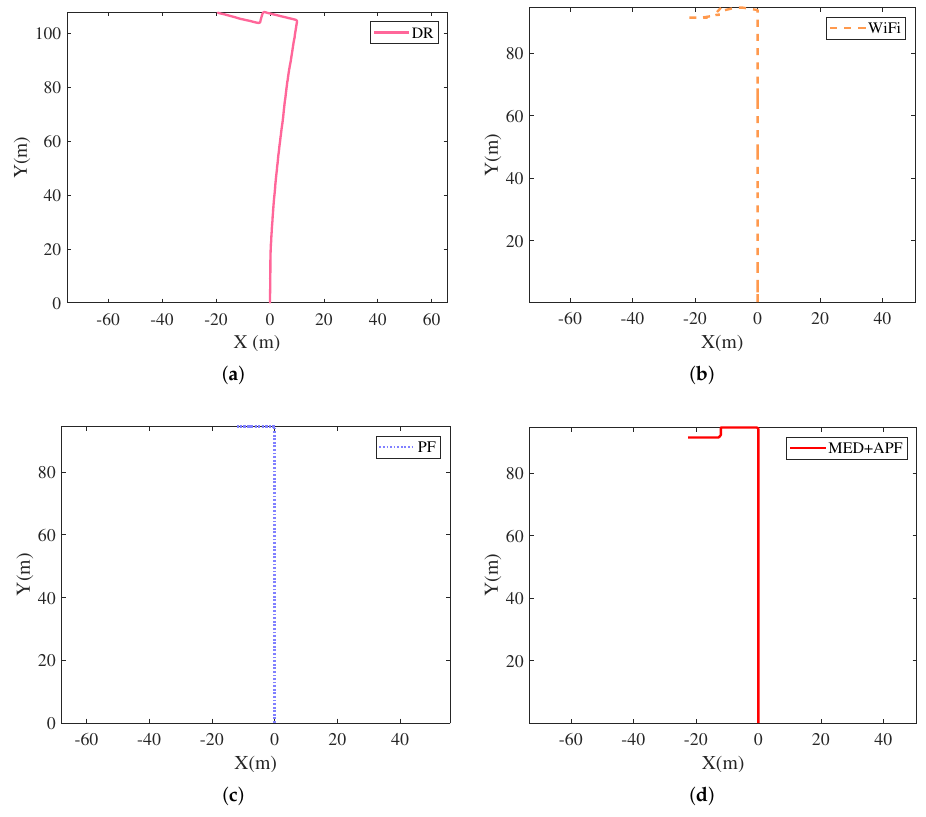
Figure 11. Positioning trajectories with different strategies. ( a ) DR; ( b ) WiFi; ( c ) PF; ( d ) MED+APF.